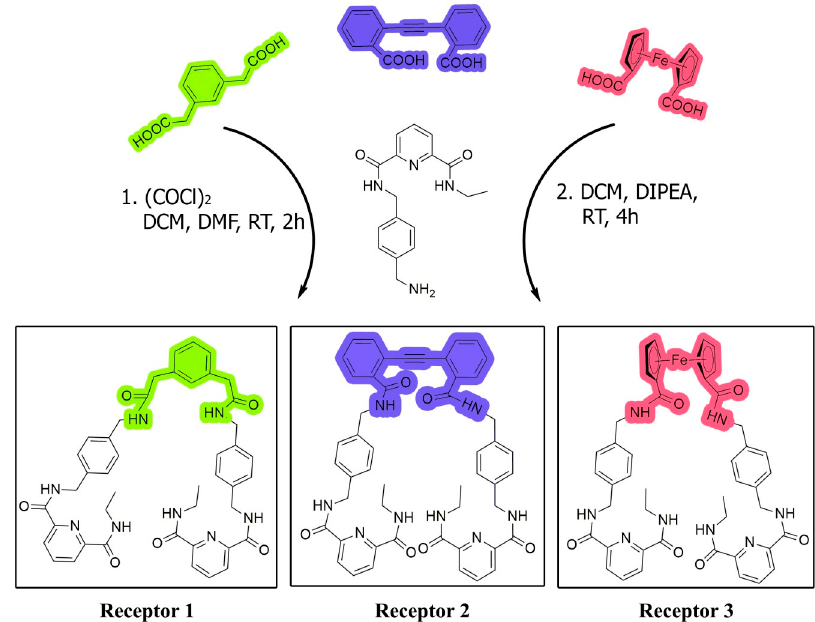
Figure 1. Synthesis of receptors with different helix-forming subunits.